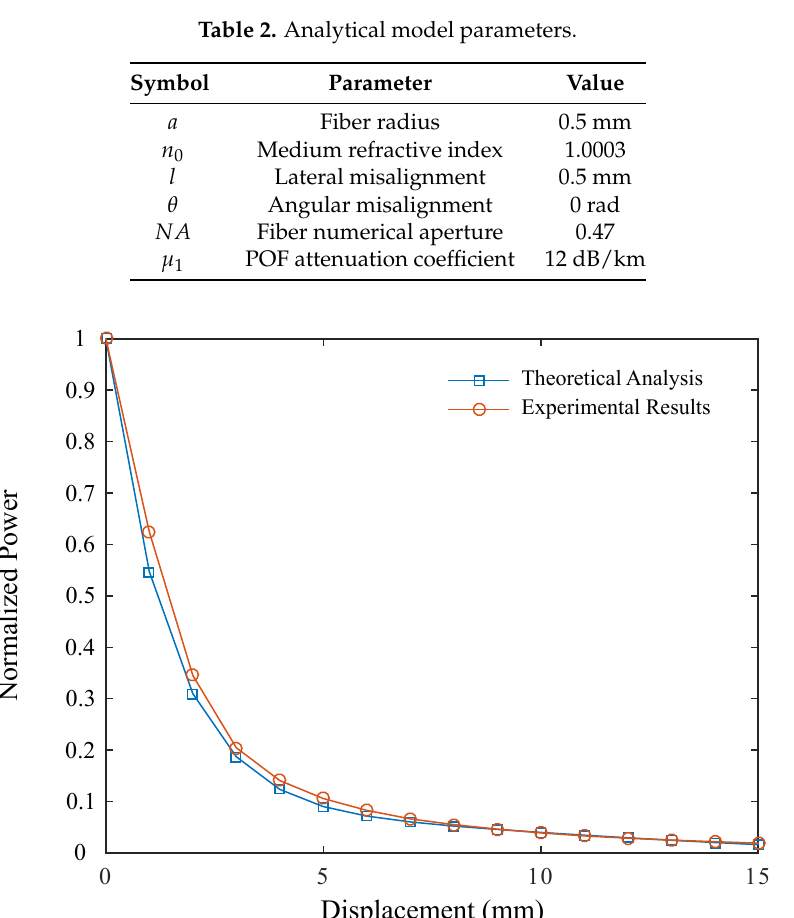
Figure 9. Experiment results for sensor-model validation. theoretical analysis (blue) compared with experiment data